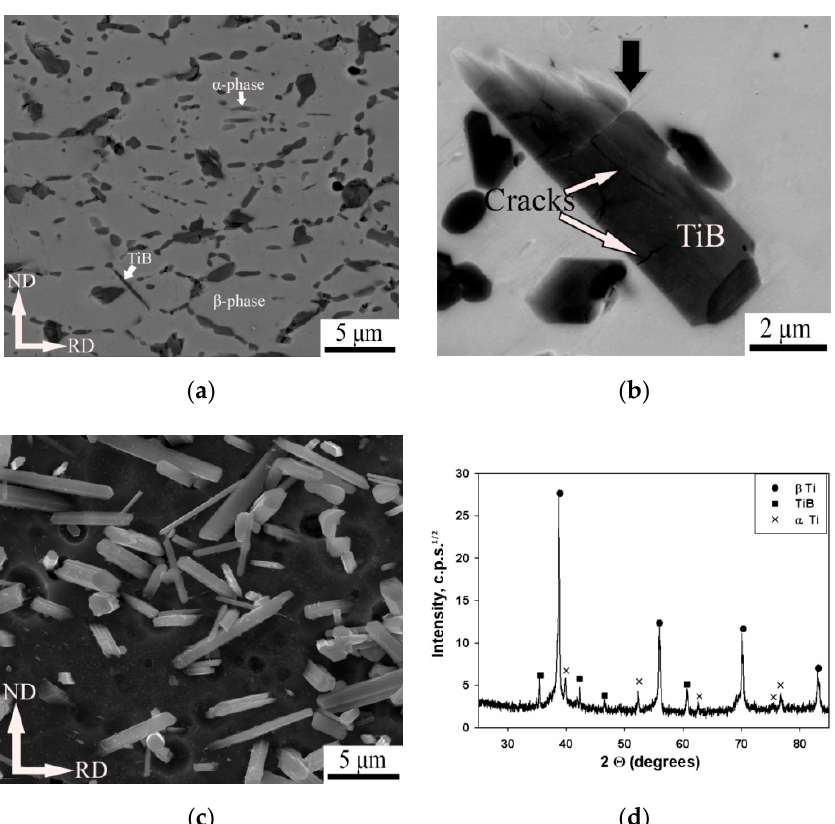
Figure 5. ( a – c ) SEM microstructure and ( d ) XRD pattern of Ti-15Mo/TiB metal matrix composite after hot rolling: ( a , b ) unetched surface; ( c ) etched surface. Rolling direction for all images is shown in the bottom-left corner of ( c ).